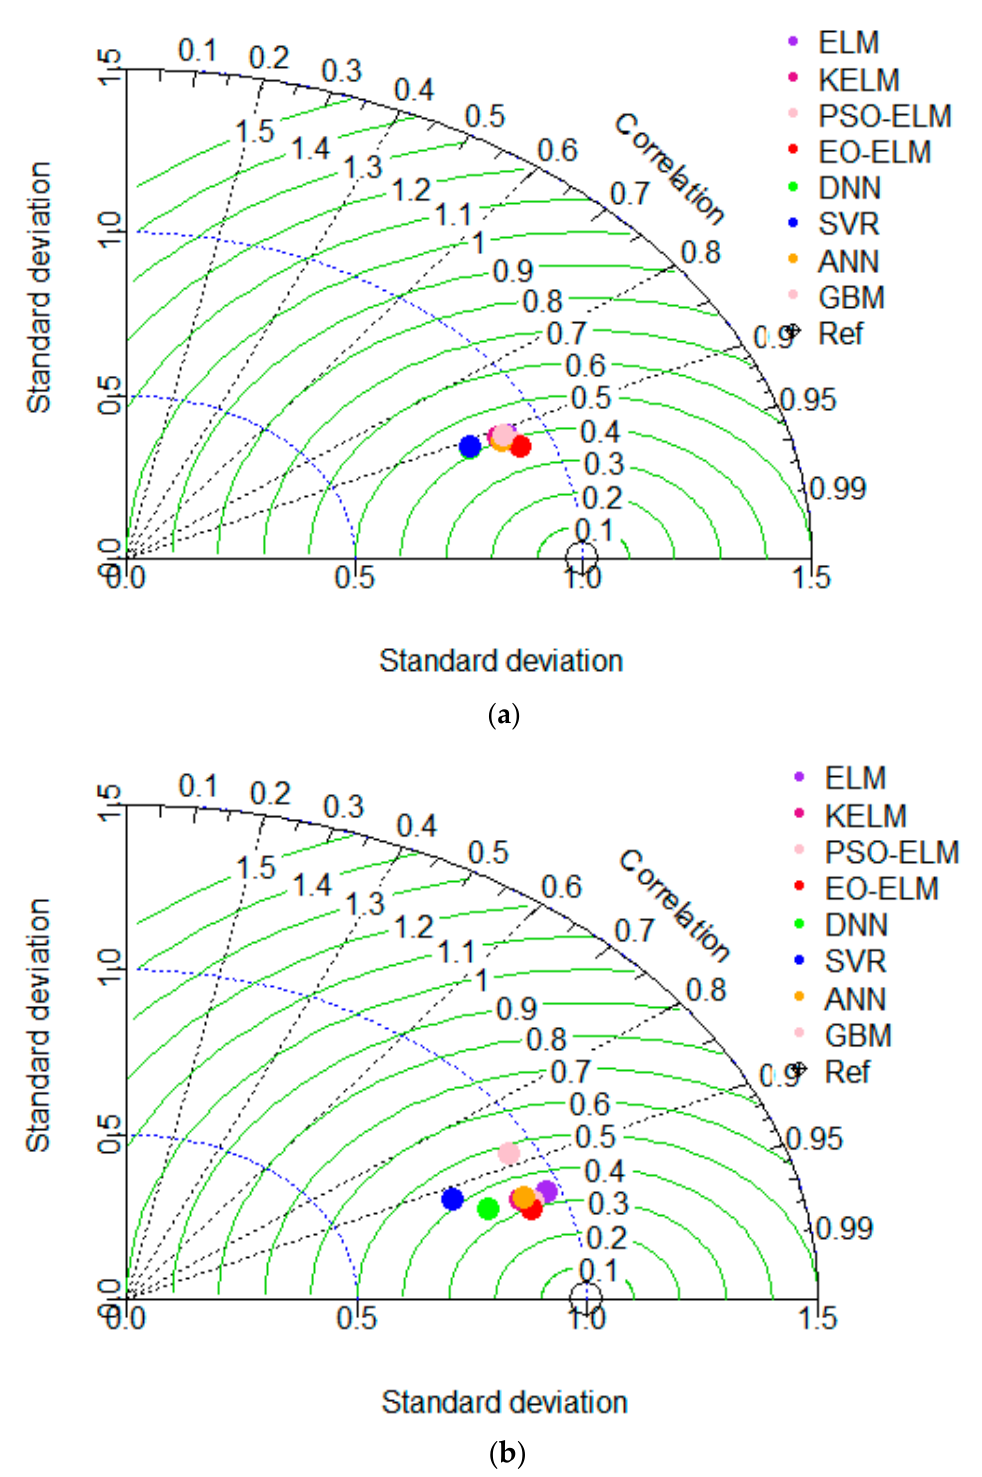
Figure 10. Statistical comparison for all models for catchment Fal at Tregony: ( a ) train, ( b ) test. Figure 11 (refer supp) and Figure 12 (refer supp) exhibit better prediction performance of EO-ELM in train (Figure 11d) and test (Figure 12d) cases, respectively, compared to other models with their linear equations for predicted and measured values. The Taylor plot (Figure 13a,b) confirms the better prediction performance of EO-ELM in terms of statistical comparison of all